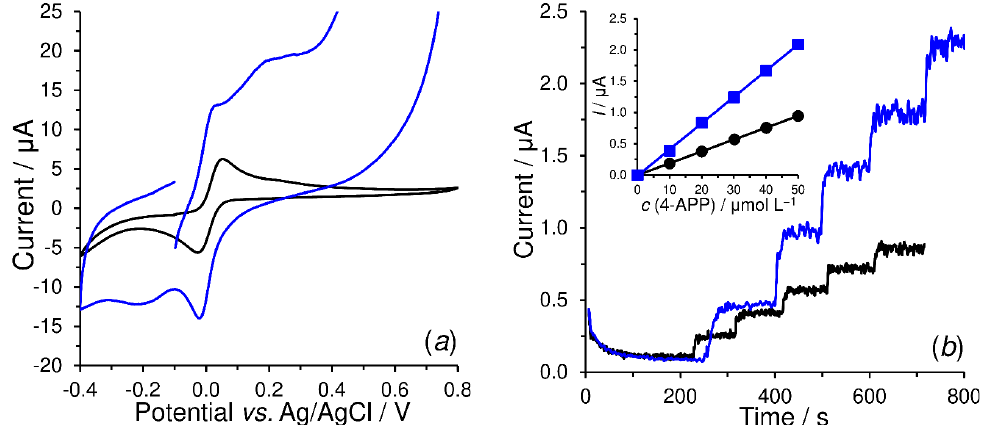
Figure 9. Cyclic voltammograms of 500 μmol L −1 p -aminophenol obtained at SPCE (black) and SPCE/PV (blue curve) in 0.1 mol L −1 CBB with 0.1 mol L −1 KCl (pH 9) at a scan rate of 10 mV s −1 ( a ). Amperograms (for batch configuration) of 10 μmol L −1 pAPP (five subsequent injections, n = 5) obtained at SPCE/ALP-GTA (black) and SPCE/PV-ALP-GTA (blue curve) in 0.1 mol L −1 CBB with 0.1 mol L −1 KCl (pH 9), when applying working potential of +0.1 V and a stirring speed of 400 rpm ( b ).